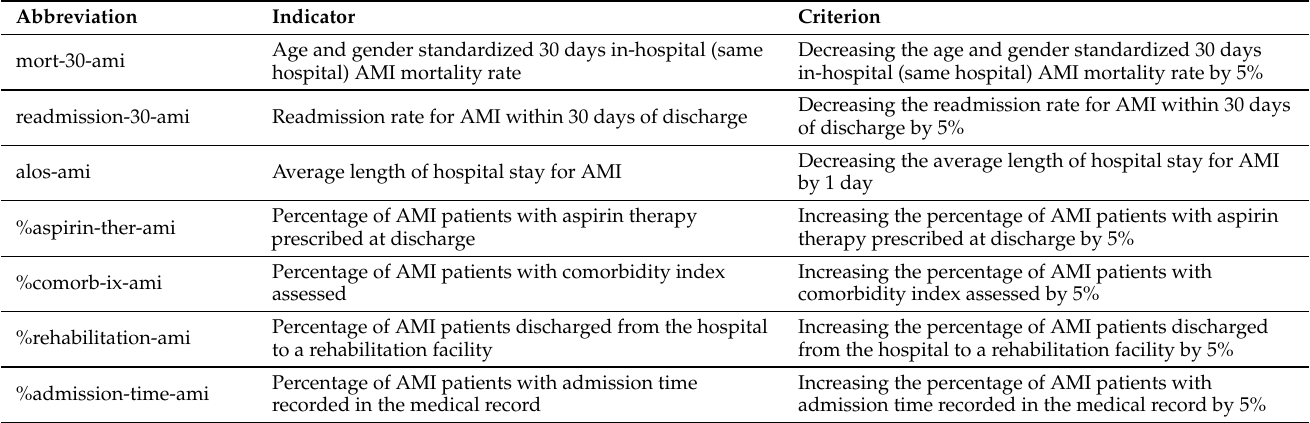
Table 3. Indicators and criteria for the acute myocardial infarction